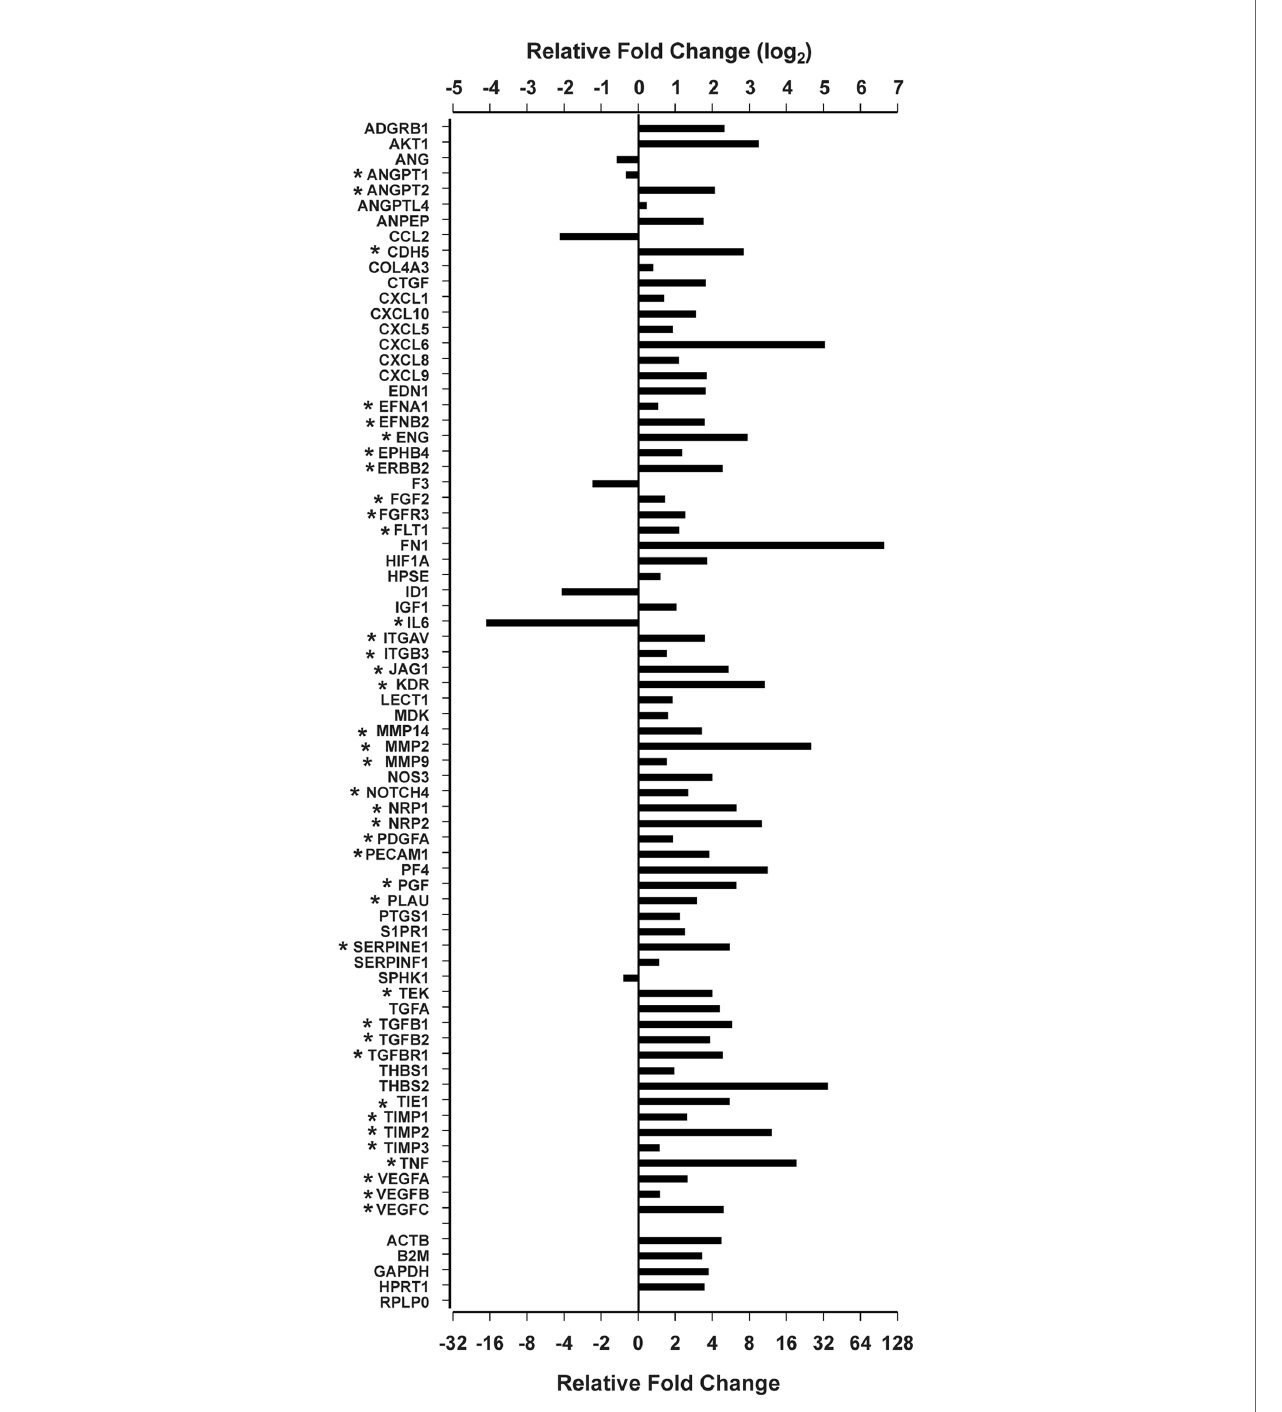
FIGURE 1 | Differentially expressed angiogenesis genes by the Qiagen RT 2 Pro fi ler PCR Array. *Genes involved in sprouting